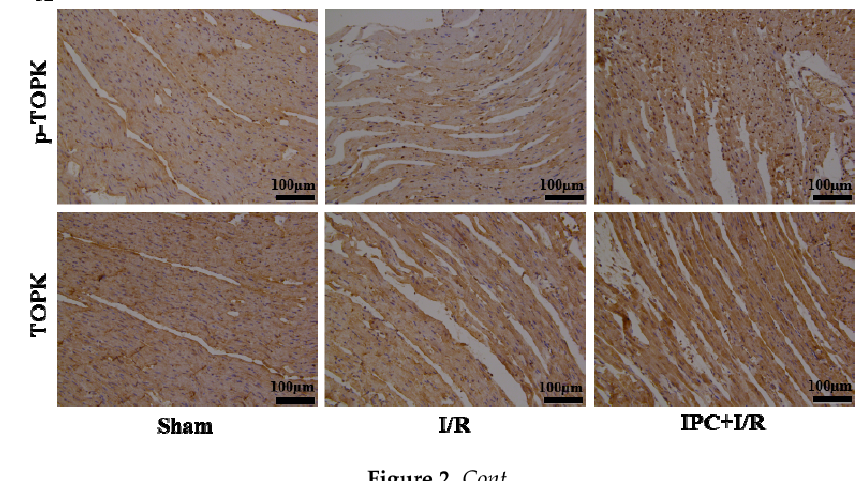
Figure 2. Cont. Figure 2.